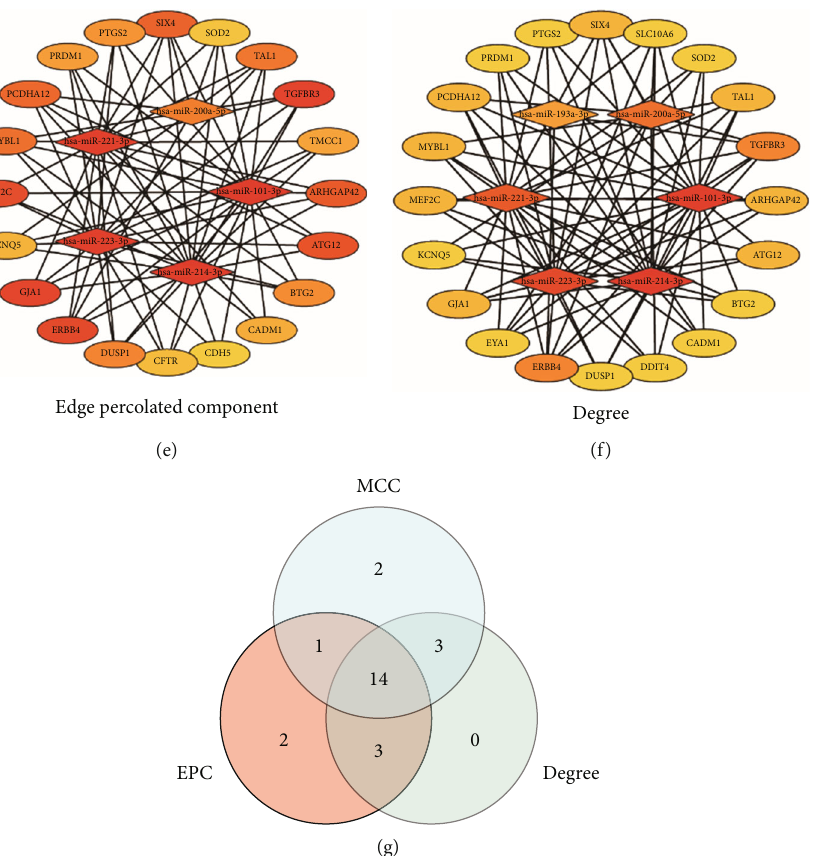
Figure 7: Construction of miRNA-mRNA interaction network and identi fi cation of hub genes. (a) Volcano plot showing di ff erentially expressed target genes in clear cell renal cell carcinoma (ccRCC) (red: upregulated; blue: downregulated). (b) Heat map showing the expression pro fi les of 59 di ff erentially expressed target genes (red: high expression levels; green: low expression levels; ns: P ≥ 0 : 05 ; ∗ P < 0 : 05 ; ∗∗ P < 0 : 01 ; ∗∗∗ P < 0 : 001 ). (c) Interaction network shows the relationship of six miRNAs and 59 di ff erential expressed target genes (red: upregulated; green: downregulated). (d) Interaction network plotted using the MCC method and Cytohubba. (e) Interaction network plotted using the EPC method and Cytohubba. (f) Interaction network plotted using the degree method and Cytohubba. (g) Venn diagram of hub